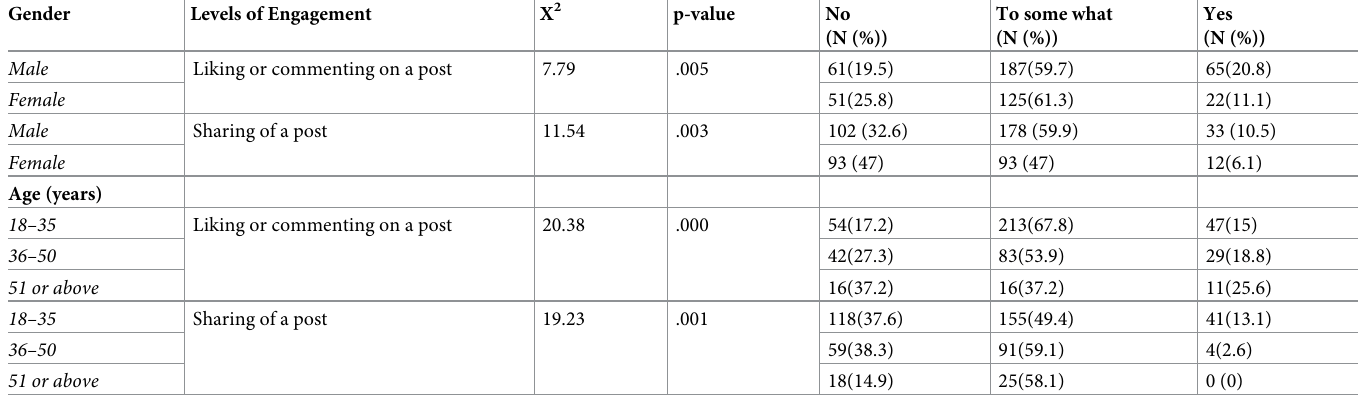
Table 3. Differences in public engagements in officials’ posts between sexes and age groups (N = 511)